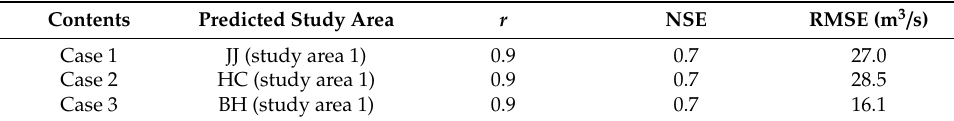
Table 6. Result of model